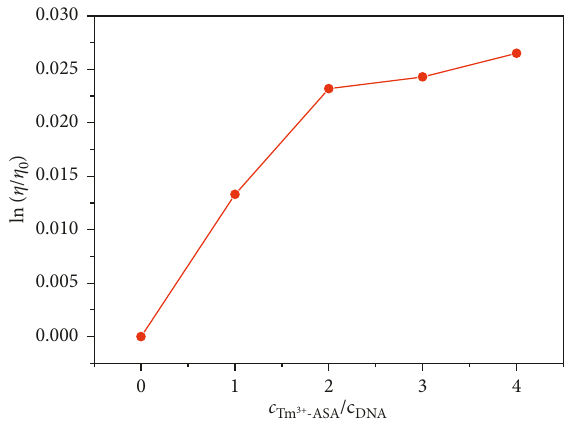
Figure 8: Effect viscosity of thulium(III)-arsenazo III on DNA (pH 7.40). c DNA (cid:31) 1, 2, 3, 4.